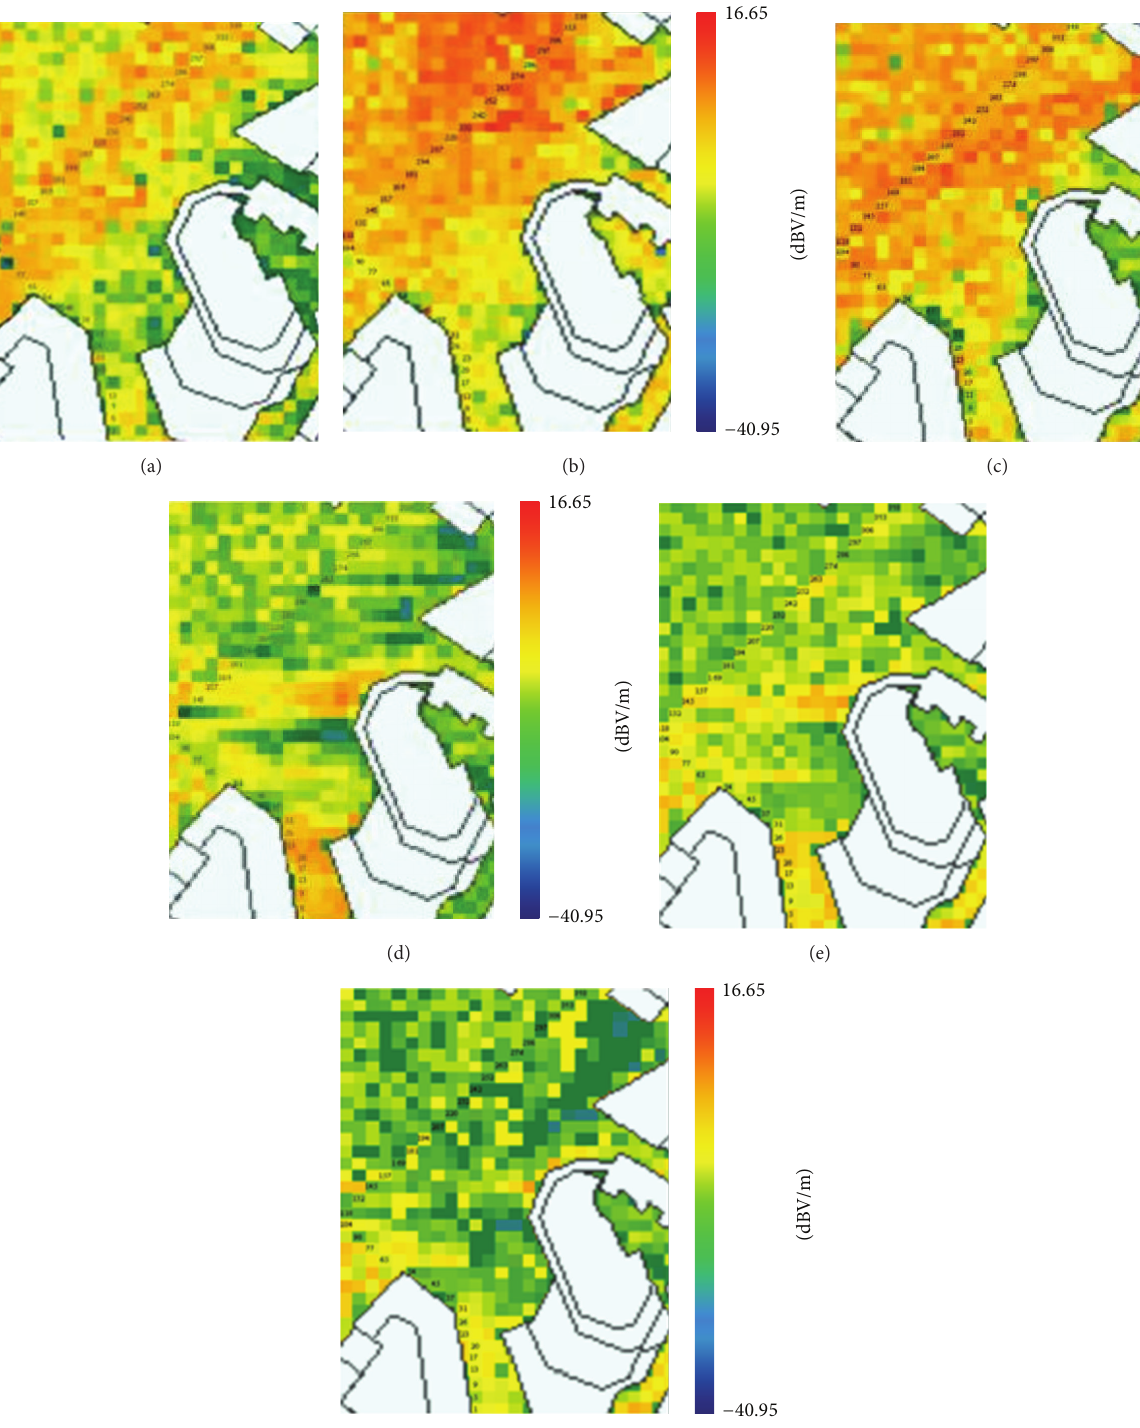
Figure 2: Software prediction of electric field strength for (a) GSM900; (b) DCS1800; (c) UMTS2100; (d) TV5–12; (e) TV21–66; (f) FM radio at Krajina Square in 320